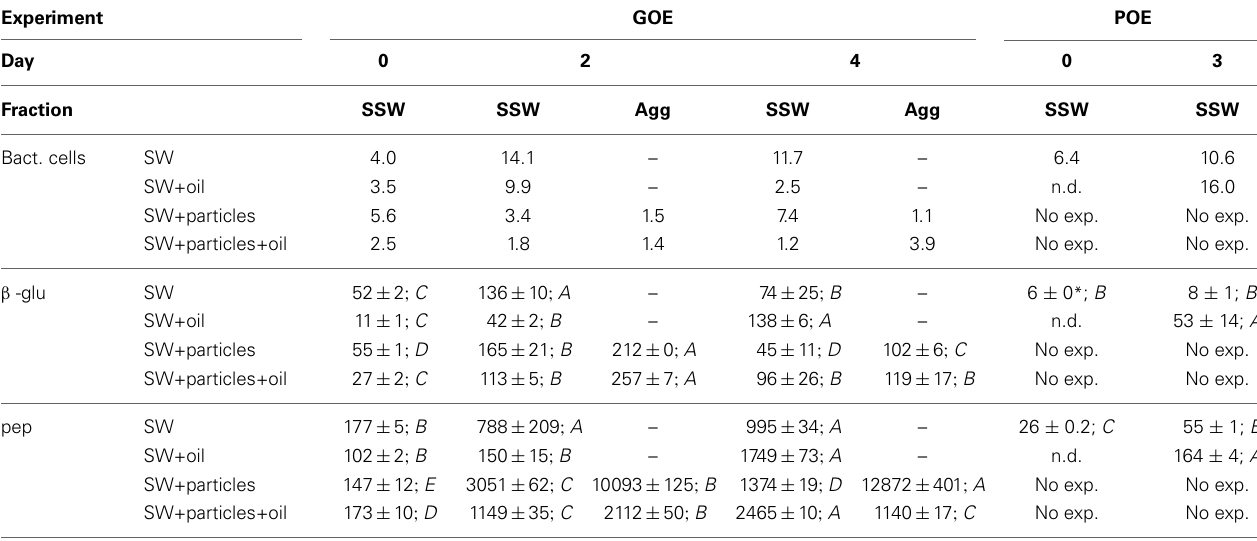
Table 3 | Bacterial abundance and cell-specific enzymatic activities.